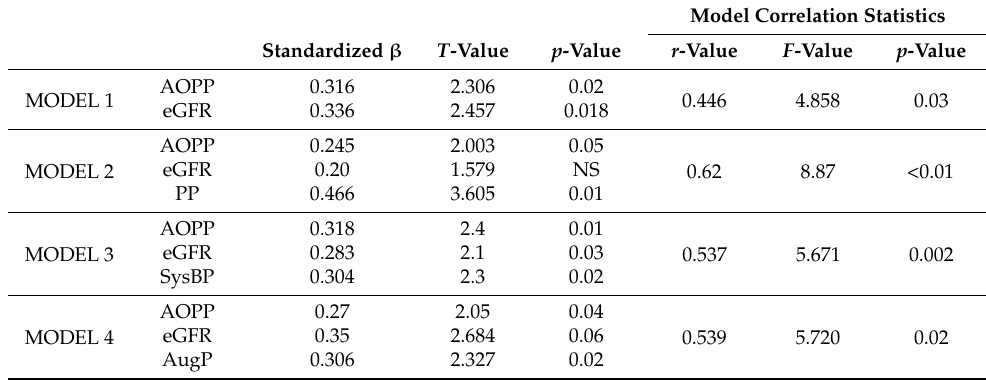
Table 3. Linear regression models for the prediction of PWV.